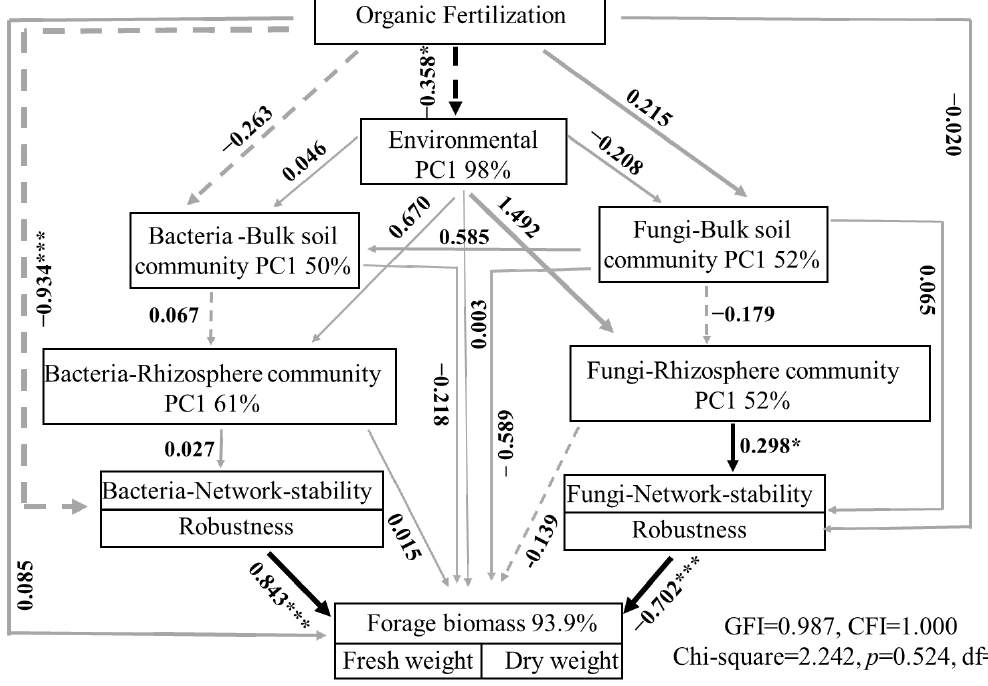
Figure 5. Model and estimate results of relationship between organic fertilizer application, microbial diversity, network attribute structure, and forage biomass. Black indicates significant correlation between potential variables, gray indicates non-significant correlation. Dashed arrows indicate negative correlation, while solid arrows indicate a positive correlation. The wider the arrow width, the greater the absolute value of the path coefficient. *** and * represent significance at p < 0.001 and p < 0.01,